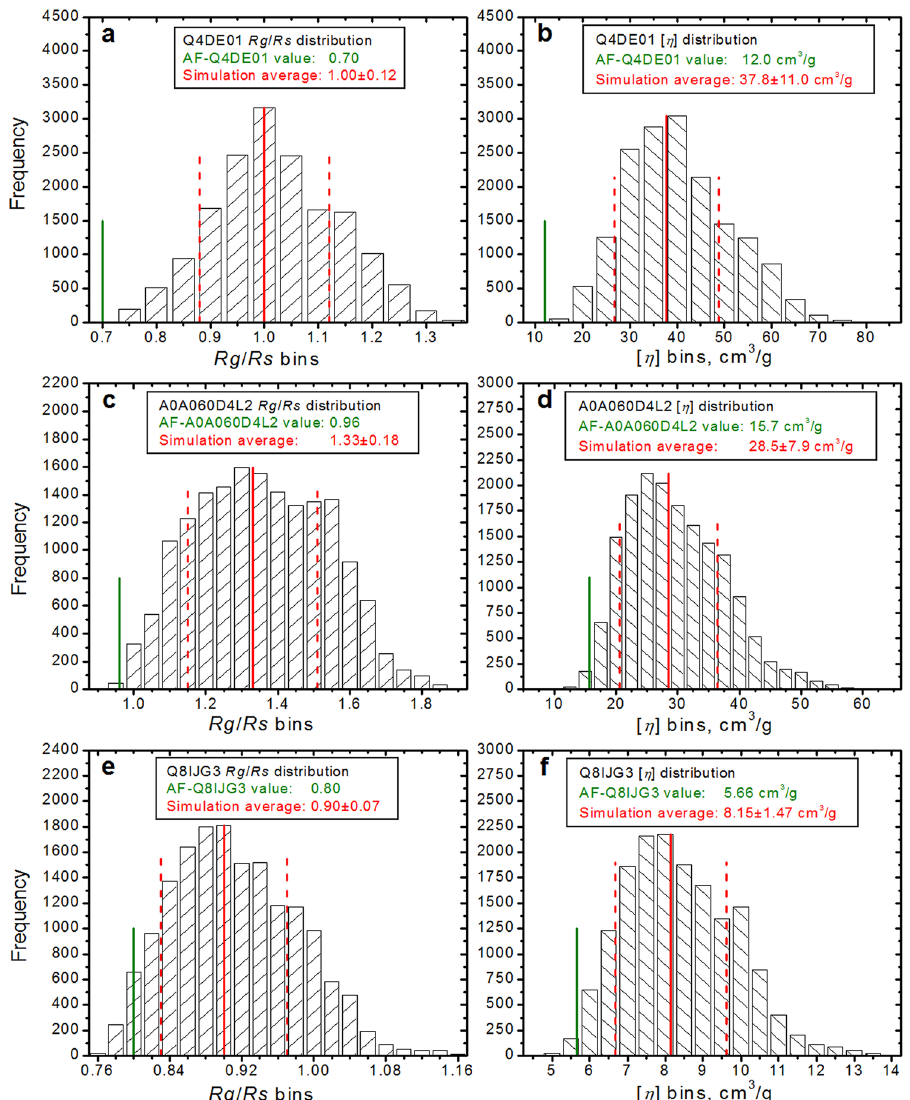
Figure 6. Histograms of the calculated parameters for the MMC-generated conformations of three AF-predicted structures from Table 2. Shown are the distributions of R g / R s ( a , c , e ) and of [ η ] ( b , d , f ) calculated for AF-Q4DE01 (16,520 conformations, ( a,b )), AF-A0A060D4L2 (16,666 conformations, ( c,d )), and AF-Q8IJG3 (16,367 conformations, ( e,f )). In each panel, the vertical green lines mark the location of the starting structure parameters, while the vertical solid and dashed red lines indicate the average ± SD over all conformations (the actual values are reported in each panel’s inside